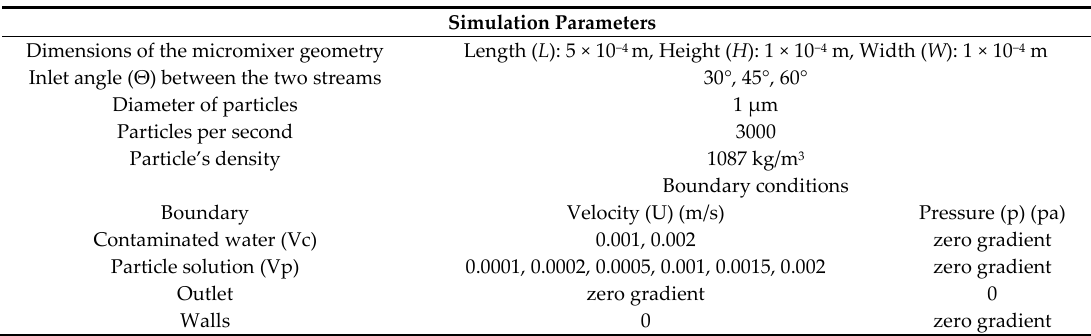
Table 1. Simulation